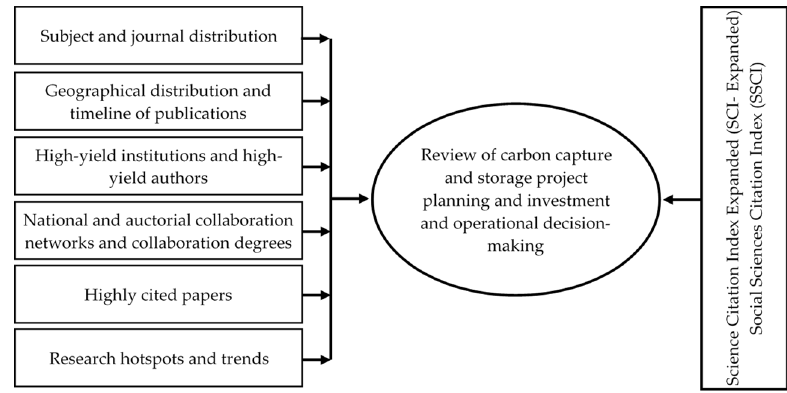
Figure 2. Research framework.